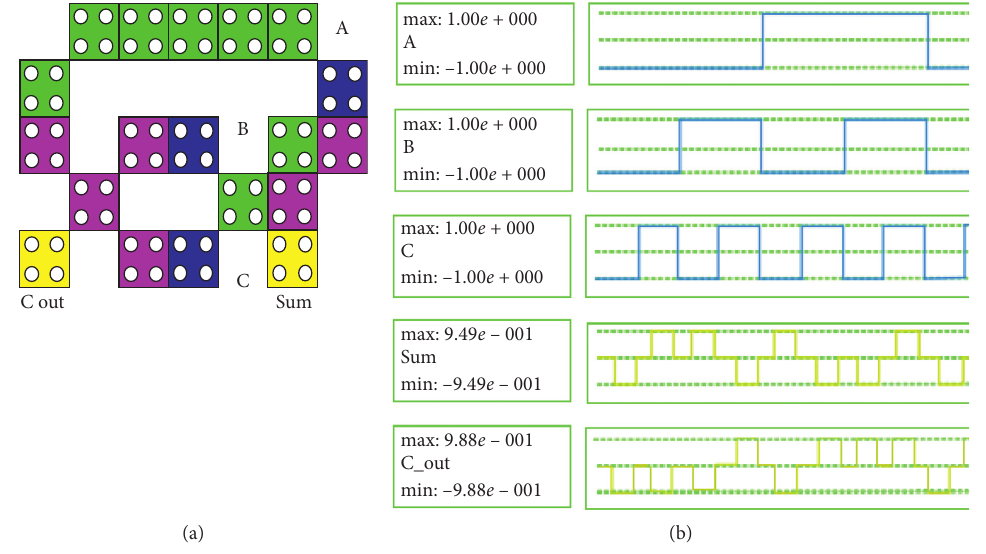
Figure 4: (a) The layout of the proposed full adder and (b) its simulation